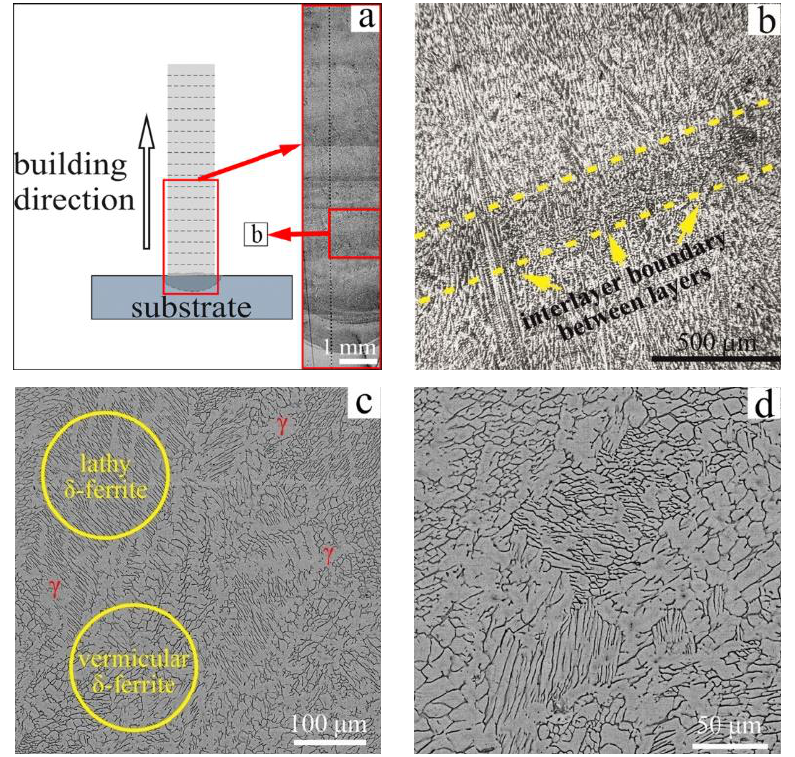
Figure 2. Light microscopy images ( a , b ) and scanning electron microscopy backscattered electron images ( c , d ) of as-built specimens. All images correspond to a cross-sectional surface along the building direction and transverse to the layers. Reprinted with permission from [7], Copyright 2020 Springer Nature.